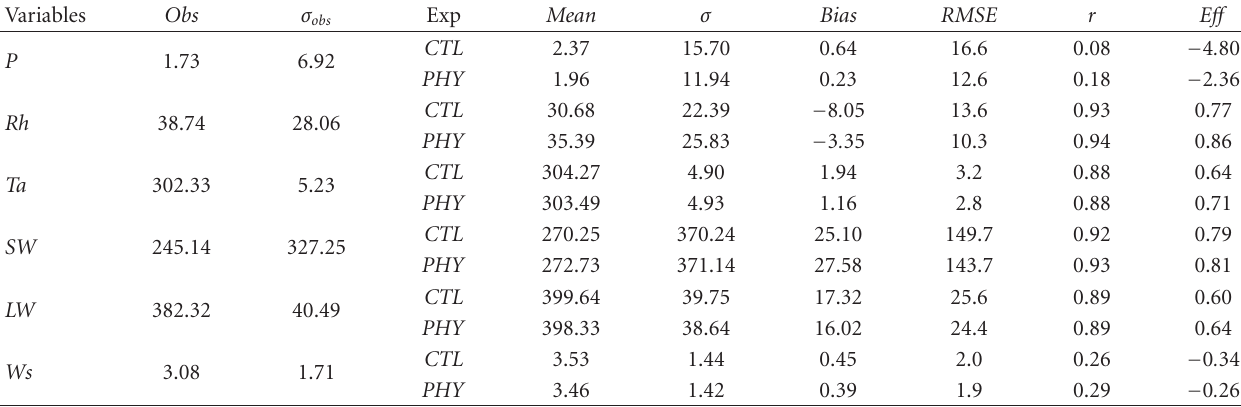
Figure 6: The 2005-2006 simulated water budgets over Dantiandou Kori: (a) each water budget component is expressed in % of total precipitations for each experiment; (b) time series of the domain average monthly total runo ff and evapotranspiration. Table 1: Simulated surface atmospheric variables versus in situ measurements in Wankama: Precipitation, P (mm/day); Relative humidity, Rh (%); 2 m air temperature, Ta (K); downward Shortwave, SW , and Longwave, LW , radiations (W/m 2 ); Wind speed, Ws (m/s). The Mean , standard deviation ( σ ), Bias , RMSE , correlation ( r ), and e ffi ciency ( E ff ) are given for all variables at a 3-hour time step, excepted for precipitation